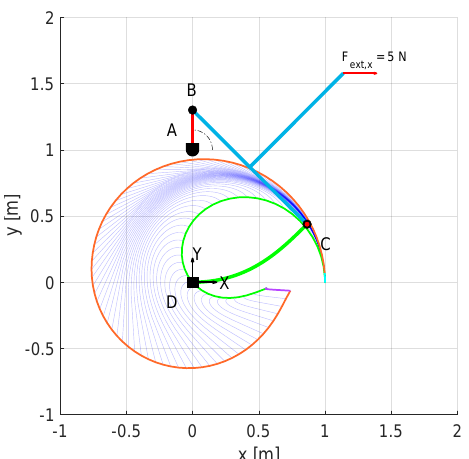
Figure 11. Cycle with buckling mode changes. α = 90 ◦